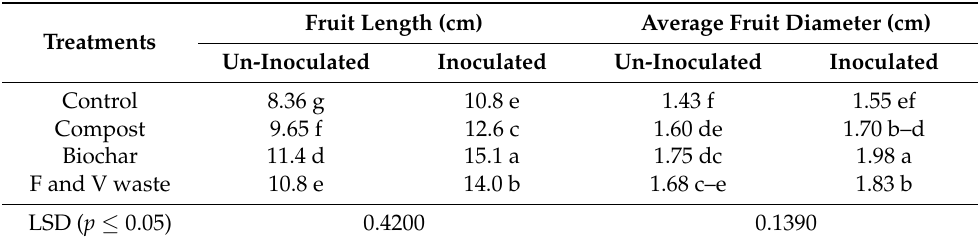
Table 7. Effect of compost, biochar, fruit and vegetable waste (F and V waste) and Bacillus subtilis SMBL 1 on fruit length and diameter in